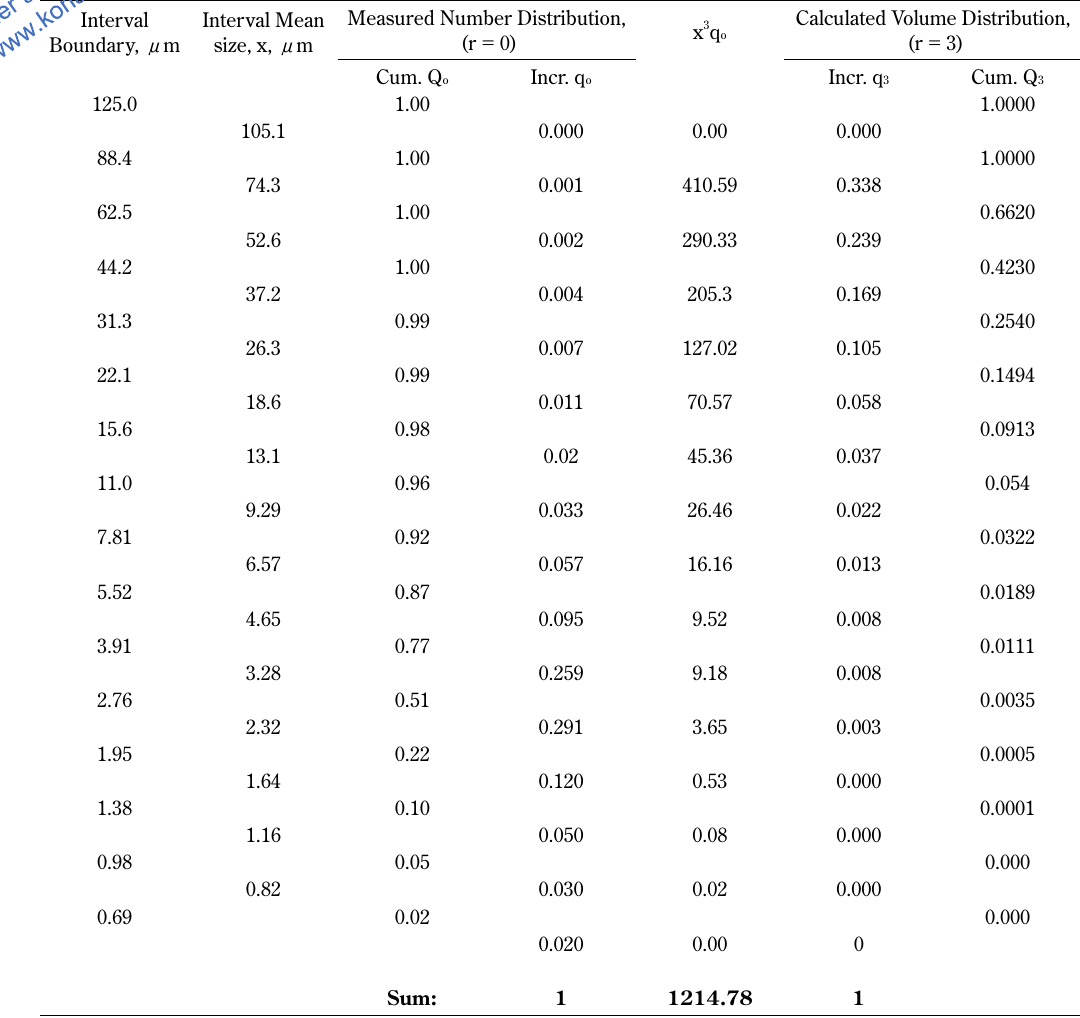
Table A1 Estimation of volume distribution by transformation from measured number distribution Interval Interval Mean Boundary, μ m size, x, μ